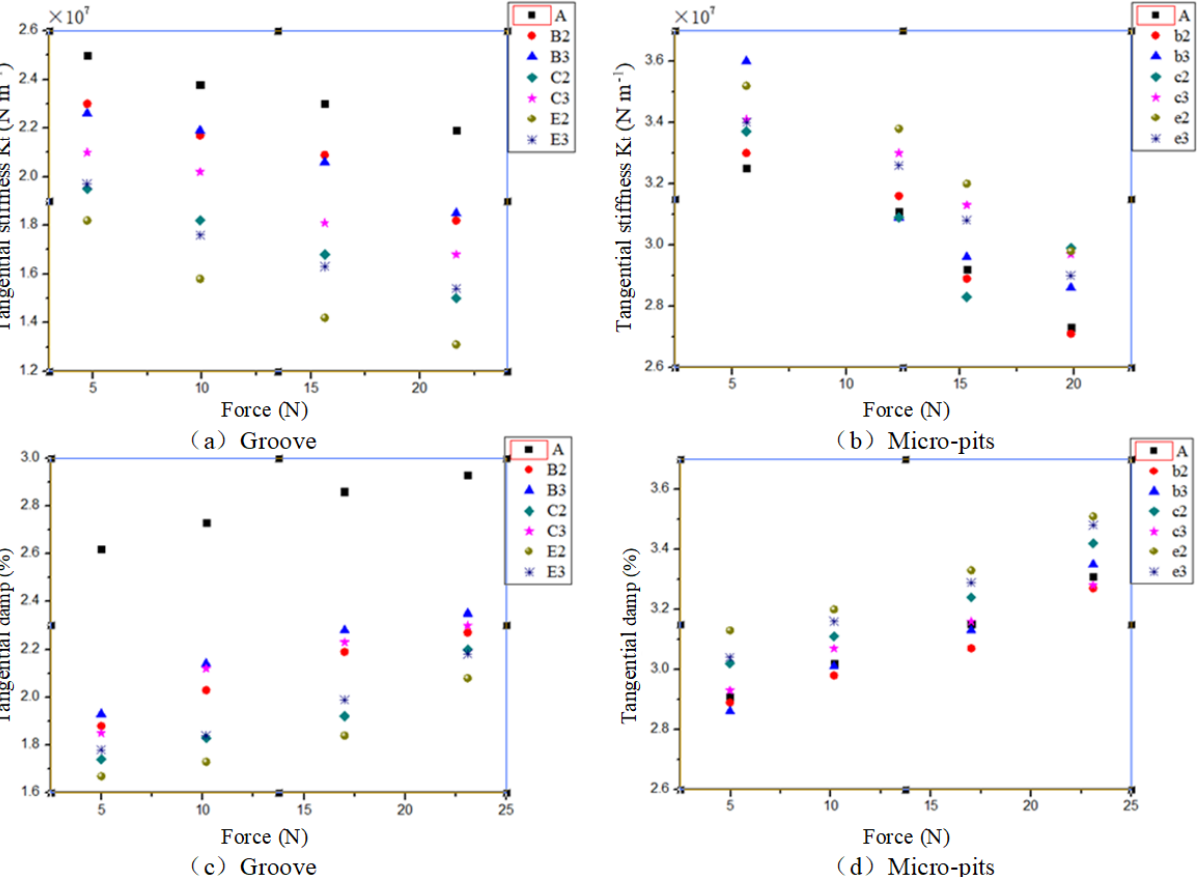
Figure 20. (a, b) The impact of texture on the tangential stiffness (groove and micro-pits). (c, d) The impact of texture on the tangential damp (groove and